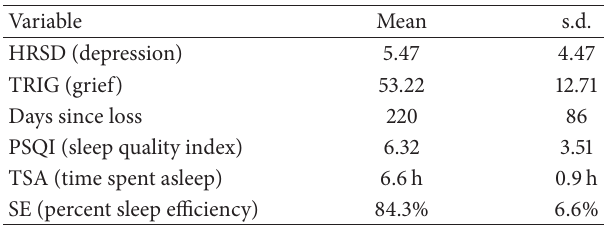
Table 1: Sample mean and standard deviation (s.d.) for each of the three predictor variables and three dependent variables. The sample size of 38 is reduced slightly for some variables due to missing data (see text).